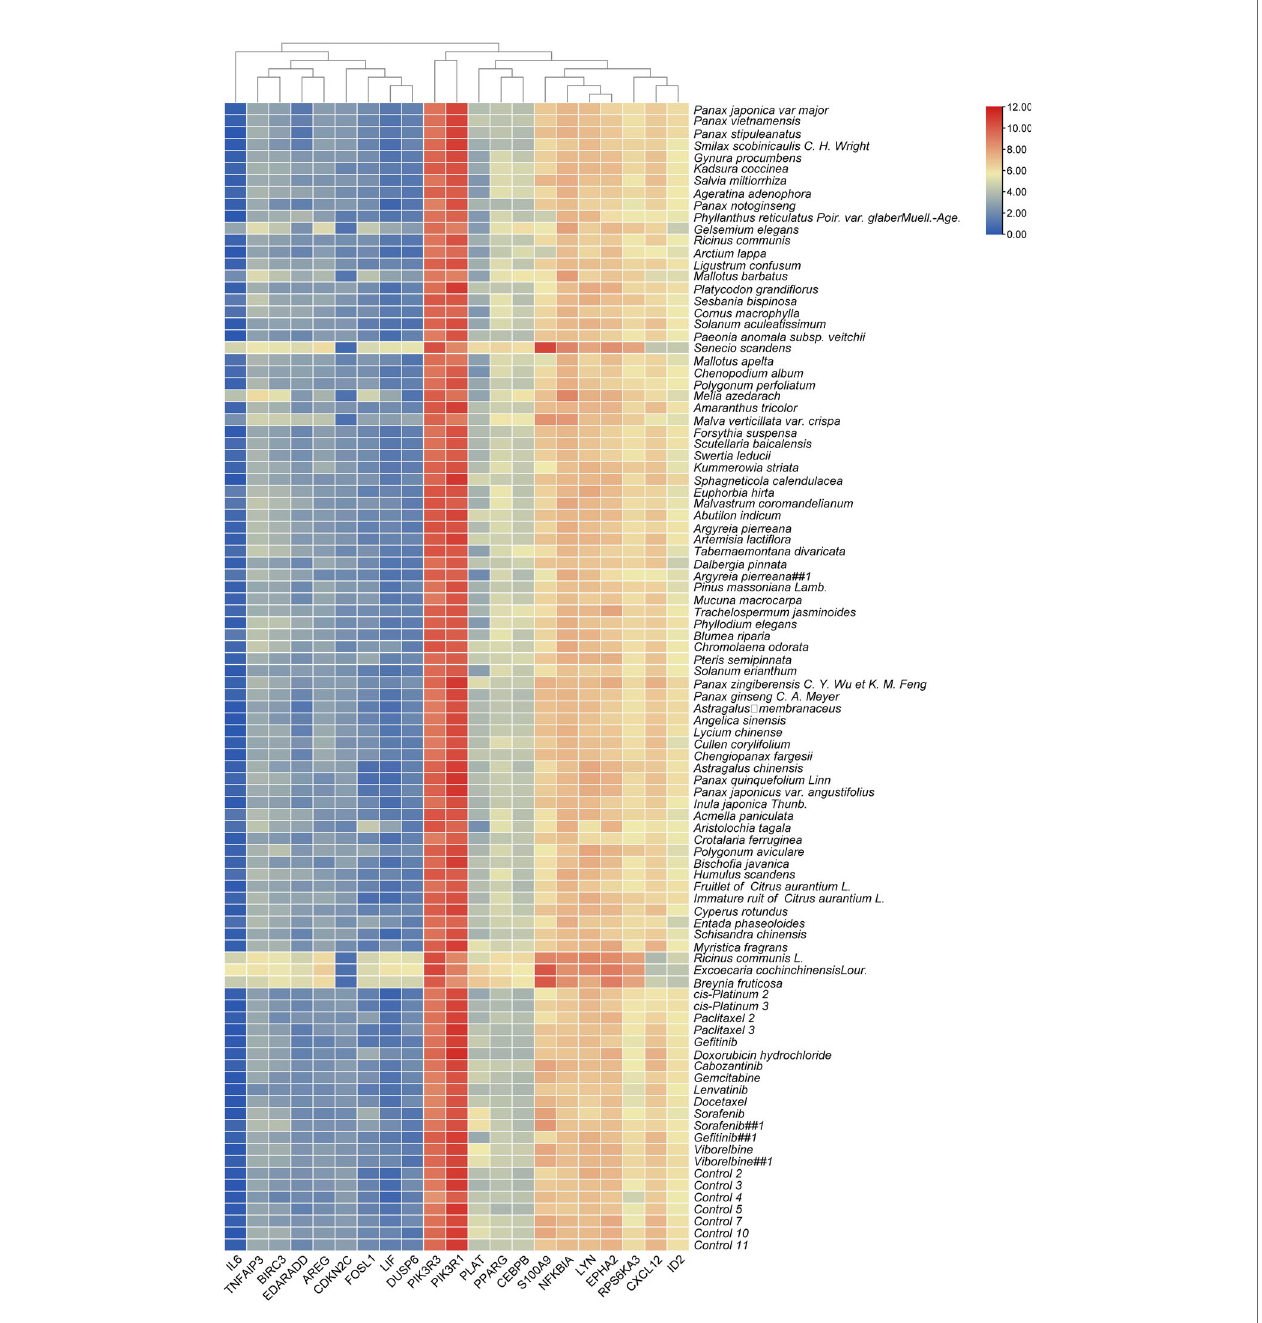
FIGURE 5 | The expression levels of common genes in different